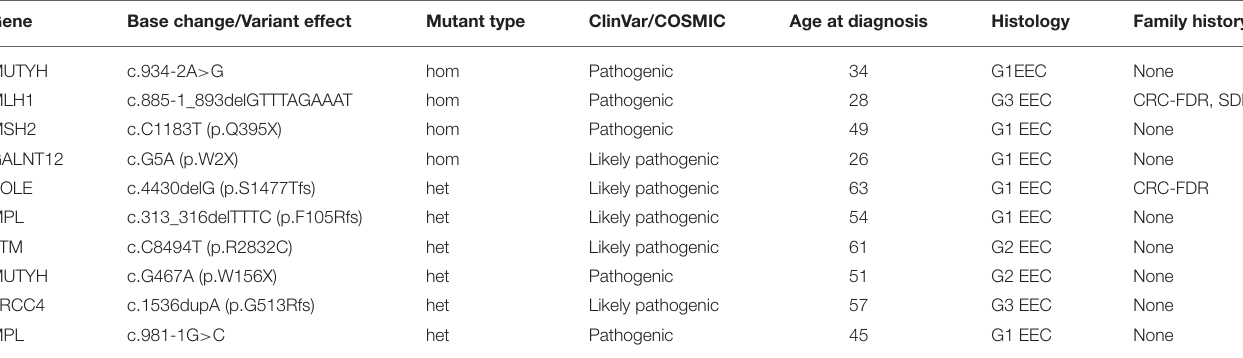
TABLE 4 | Ten patients with germline mutations in 363 genes detected using NGS of 115 paired